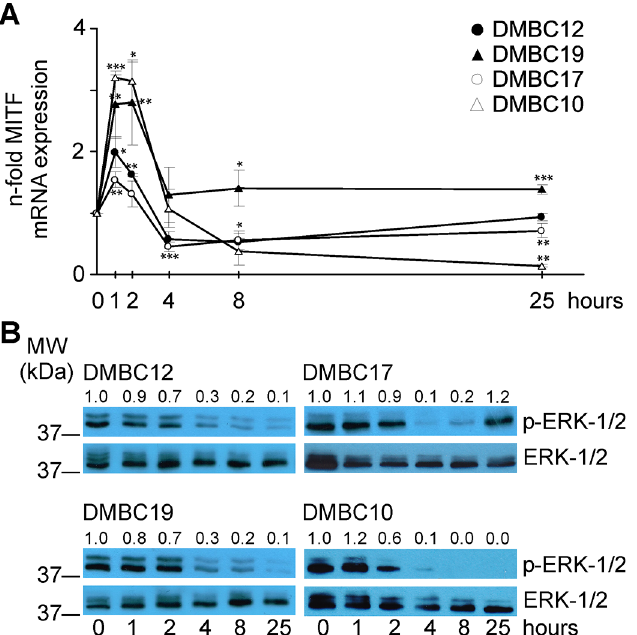
Fig 6. Immediate response to changes in microenvironment involves alterations in MITF level and ERK-1/2 activity. (A) Level of MITF mRNA was analyzed at indicated time points during early adaptation period of melanoma cells to serum-containing medium. Data are presented as the means ± SD from three independent experiments. * p < 0.05; ** p < 0.01; *** p < 0.001. (B) Immunodetection of phosphorylated ERK- 1/2 Thr202/Tyr204 (p-ERK-1/2) was used a readout of their activity (n = 3). Localization and molecular weight (MW) of marker bands are indicated. ERK-1/2 was used as a loading control. Quantification of p-ERK-1/2 level is shown above the